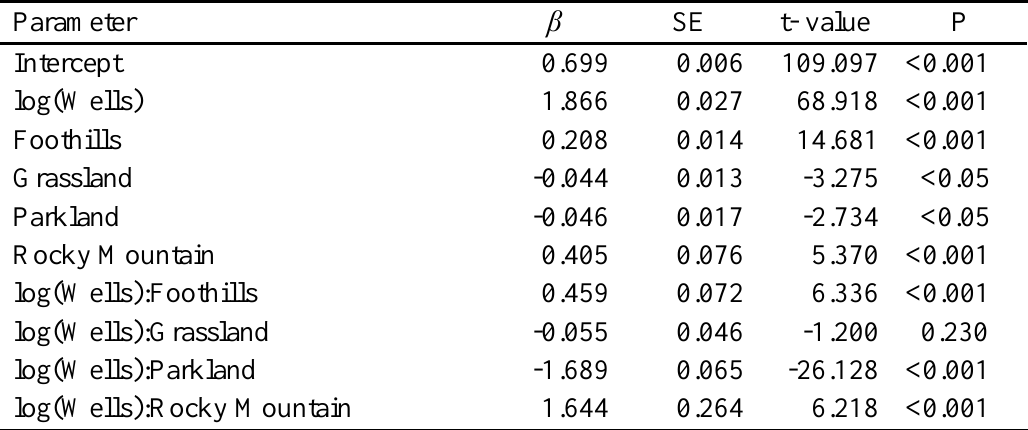
Table A2.2. Parameter estimates for predicting proportion of townships disturbed by pipeline right-of-ways. Note: the predictions must by squared due to square root transformation of the response variable prior to